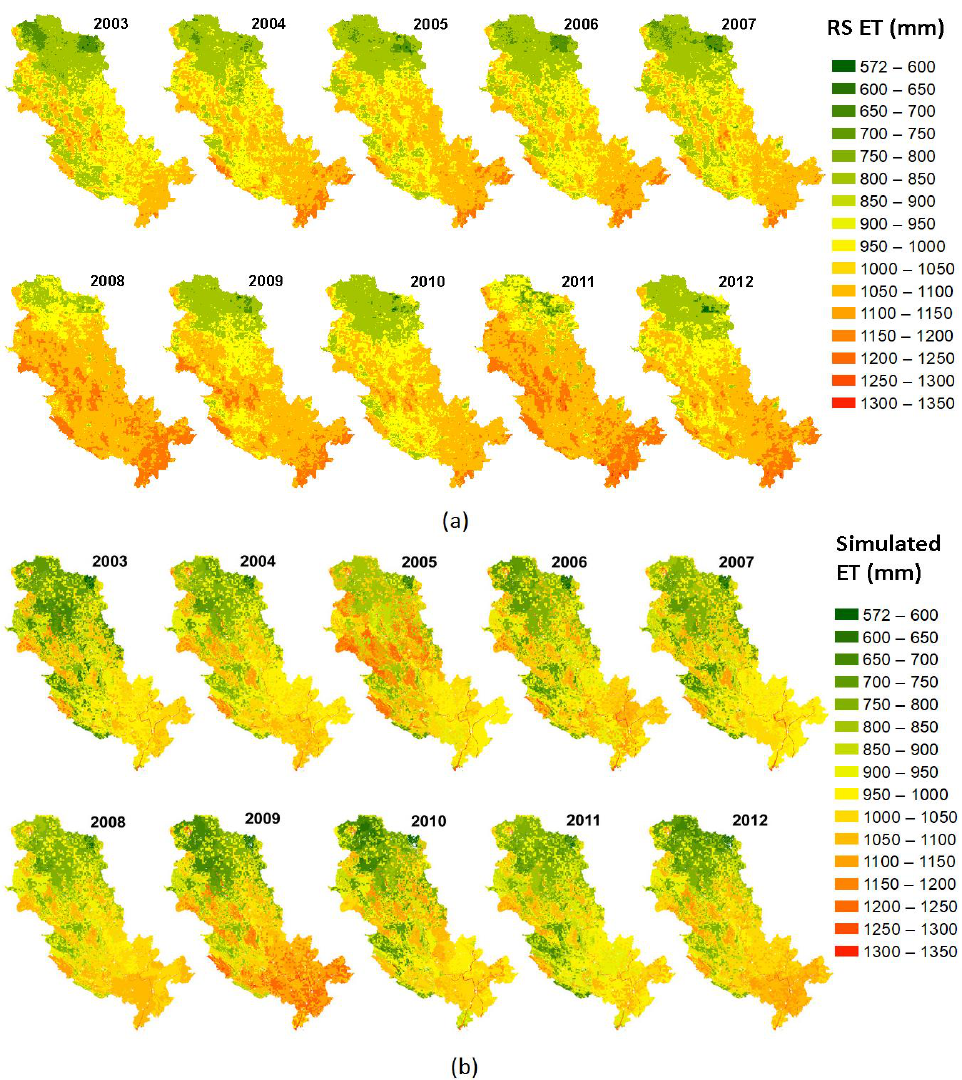
Figure 10. Spatial agreement between the ensemble ET from remote sensing ( a ) and the SWAT simulated ET ( b ) at an annual basis.